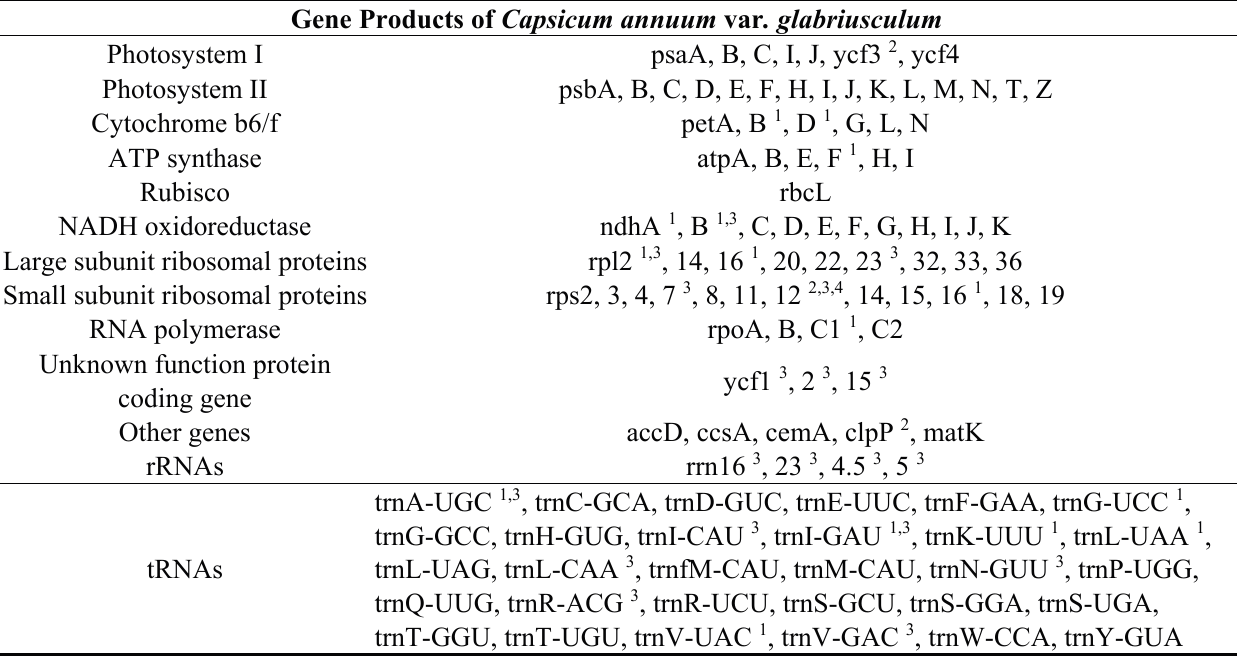
Table 2. Genes present in the C. annuum var. glabriusculum chloroplast